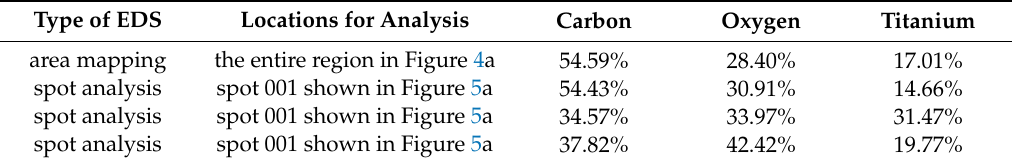
Table 1. Atomic mass content from area mapping and spot analysis.